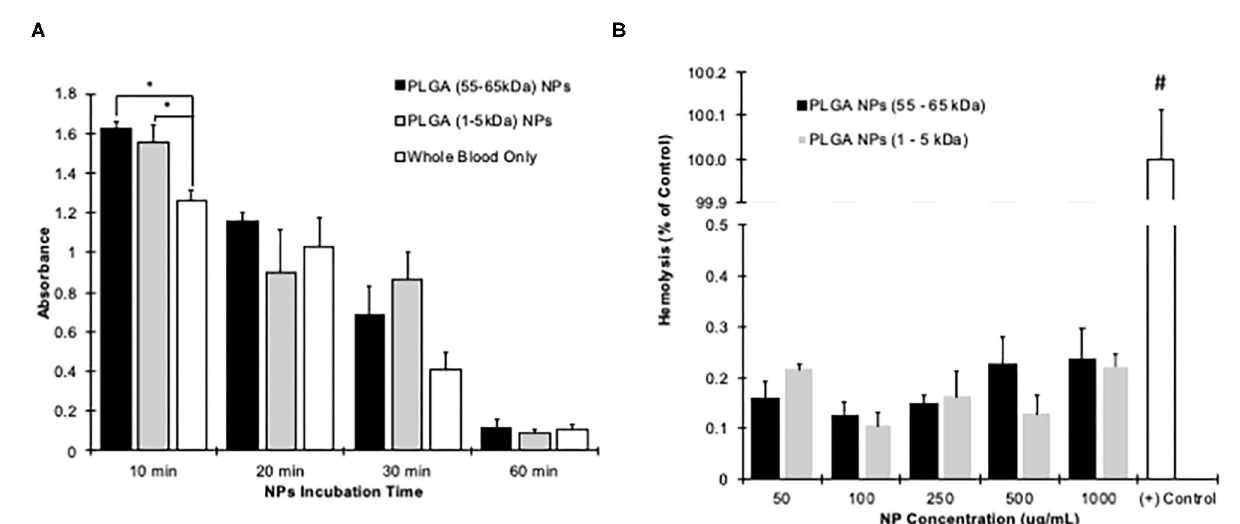
FIGURE 3 | Hemocompatibility of PLGA nanoparticles. (A) Nanoparticles at a concentration of 1 mg/mL were subjected to human blood for up to 1h. The clotting was significantly affected only during the first 10min of nanoparticle exposure ( p < 0.05). At all other time points, the nanoparticles did not affect the clotting ability of the human blood. Blood exposed to only air was kept as a control. *Denoted a significant difference with p < 0.05 evaluated via one-way ANOVA at each time point. (B) Nanoparticles were incubated with blood for 1h. Compared to RO water treatment (Positive control), both nanoparticle groups had significantly less hemolysis at all tested concentrations. #Indicates that the Positive control is significantly higher than all other groups with p < 0.05 evaluated using a two-way ANOVA. All data is shown as mean + standard error.